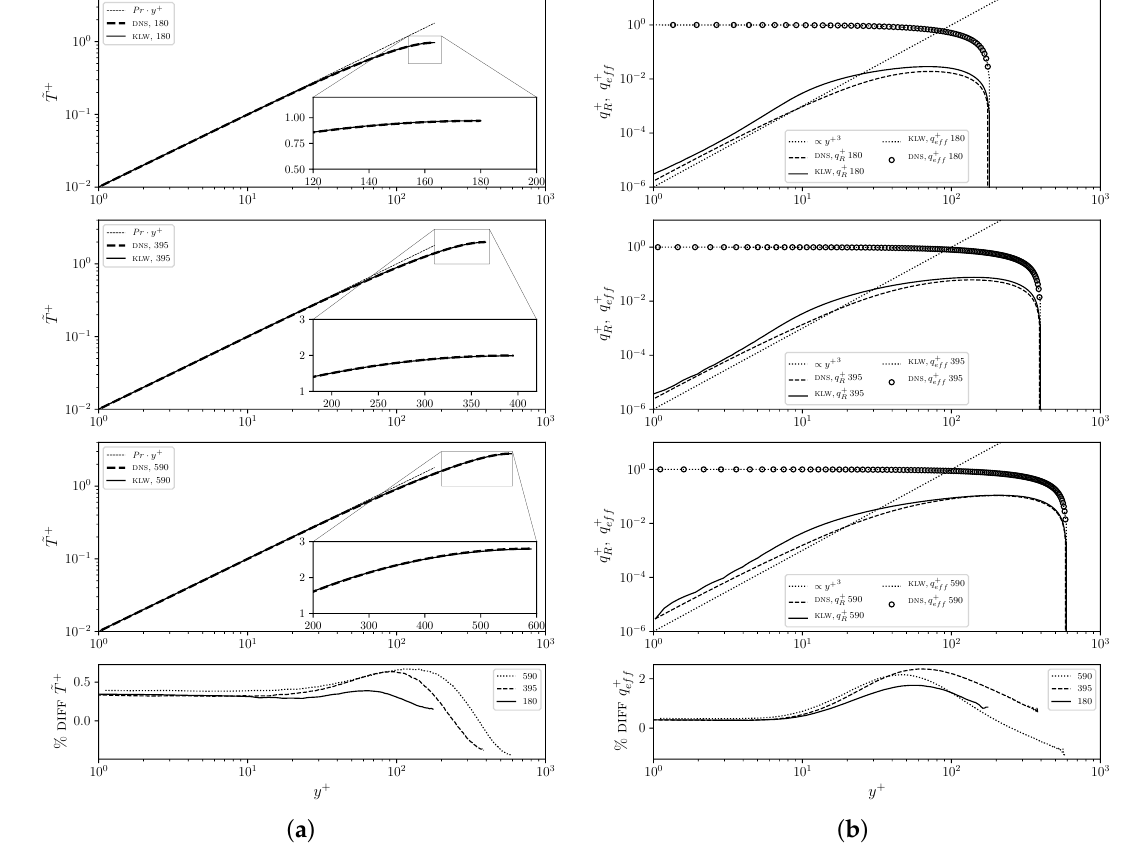
Figure 2. Two-dimensional channel tests ( Pr = 0.01). Non-dimensional mean temperature ˜ T +